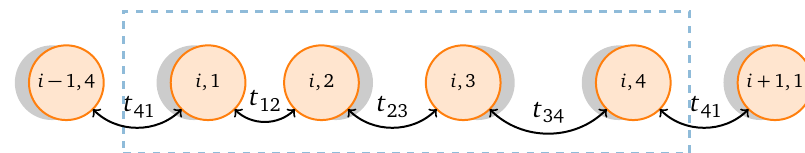
). The double 2 . The atoms are labeled by their unit-cell ij